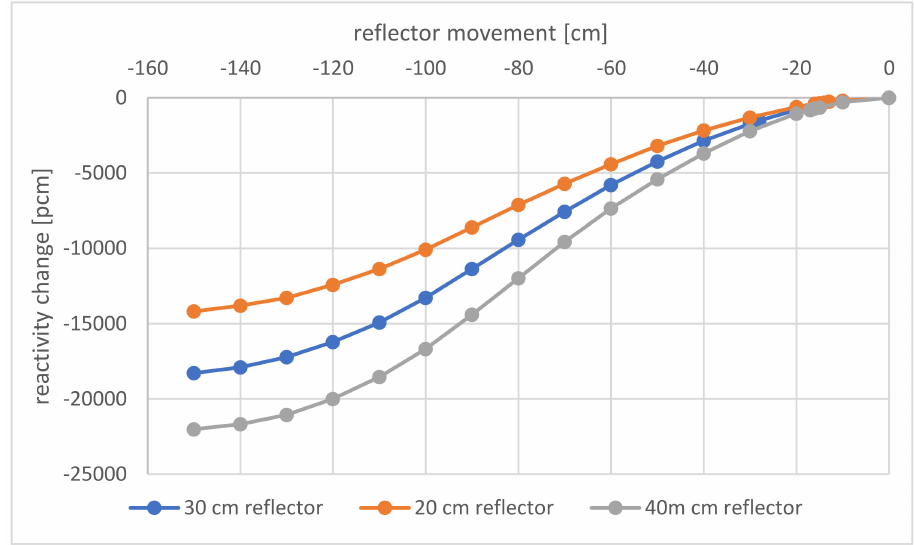
Figure 11. Control reactivity curve dependent on the stepwise downward movement of the reflector for systems with different thicknesses of the